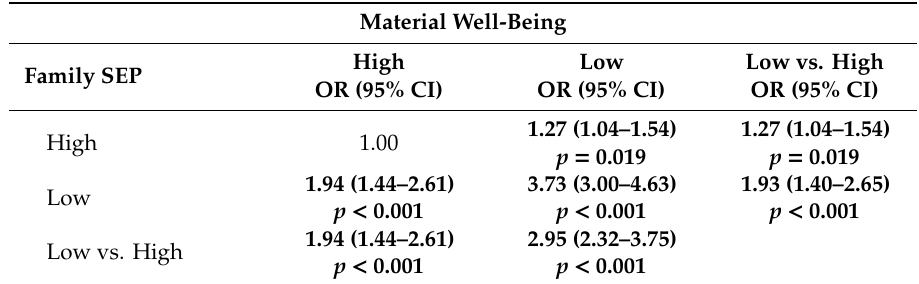
Table 5. Odds ratios (95% confidence interval) of low psychosocial well-being by the interaction of family socioeconomic position and material well-being, adjusted for age and